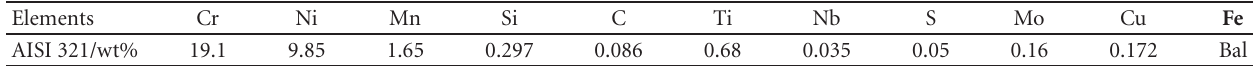
Figure 1: Interfacial defect generation-annihilation reactions that are postulated to occur in the growth of anodic barrier oxide films χ − = cation vacancy on the metal sublattice of the barrier layer, M χ + according to the PDM. m = metal atom, V M = metal cation on the metal sublattice of the barrier layer, V ·· = oxygen vacancy on the oxygen sublattice of the barrier layer, O O anion on the oxygen sublattice of the barrier layer, M Γ + = metal cation in solution [10–13]. Table 1: Nominal chemical composition of AISI 321 stainless